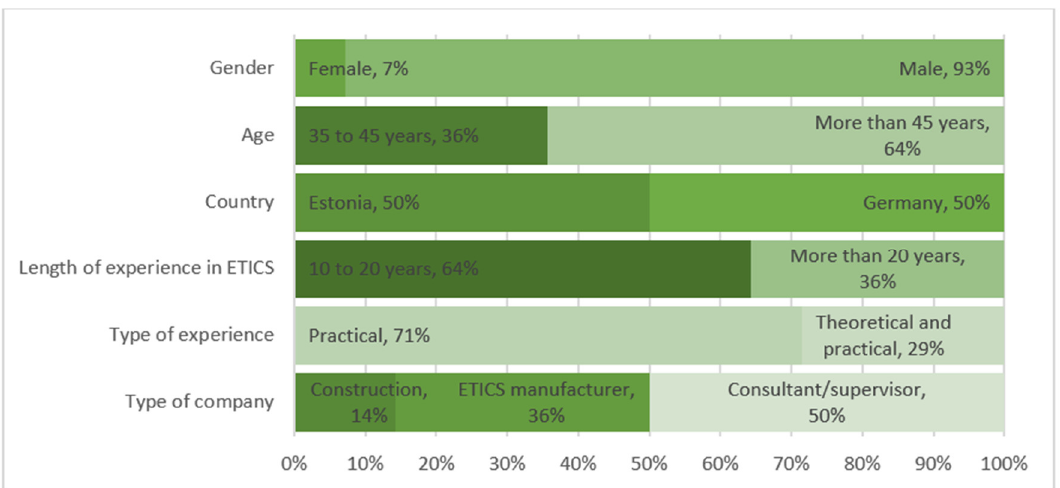
Figure 3. Demographics of the experts included in various areas of research.